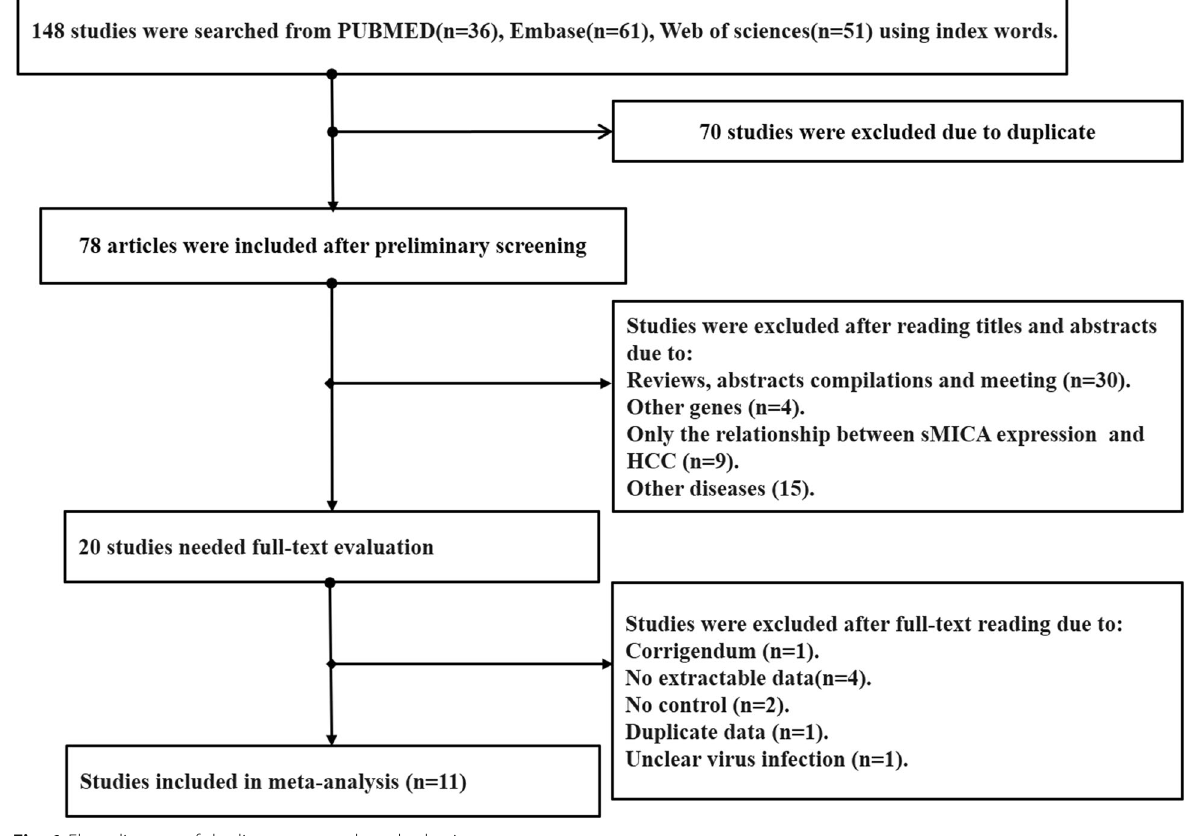
Fig. 1 Flow diagram of the literature search and selection